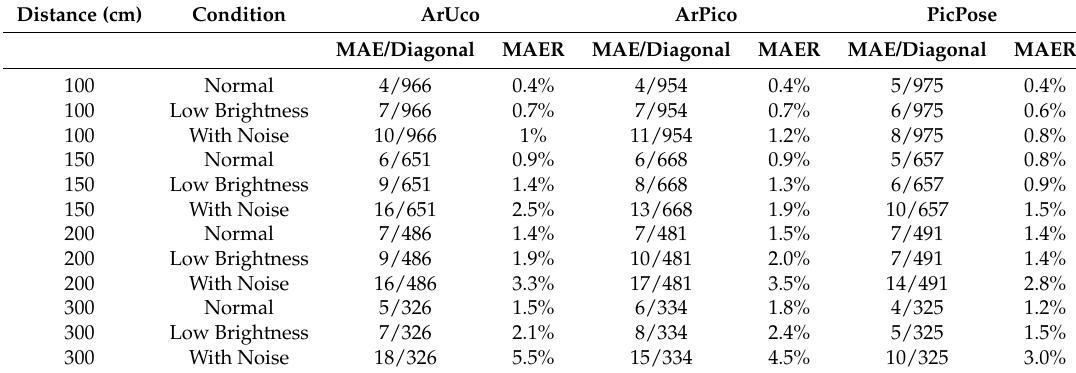
Table 2. Pictorial Marker Matching